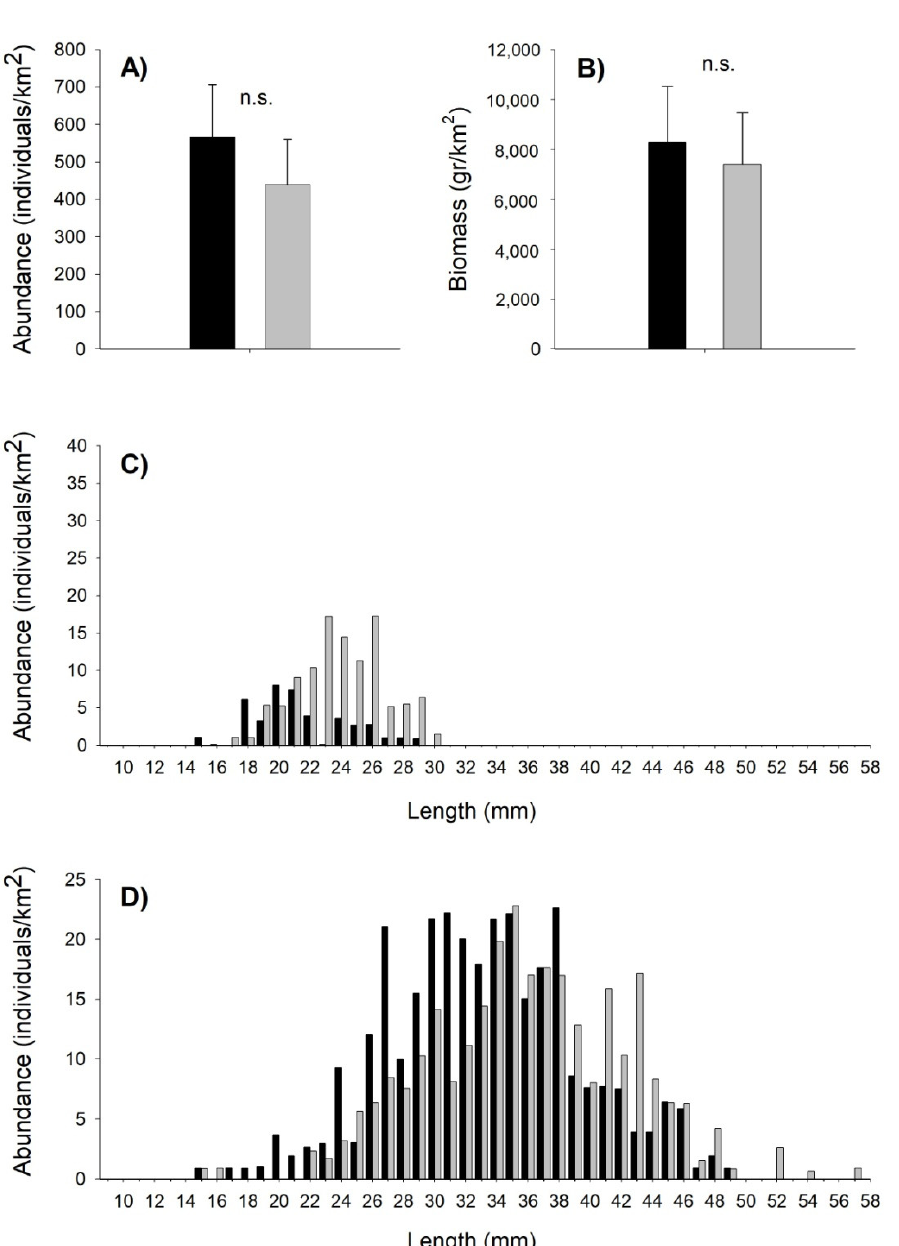
Figure 7. Mean standardized abundance ( A ) and biomass ( B ) and length frequency distribution by males ( C ) and females ( D ) of red shrimp ( Aristeus antennatus ) at fishing grounds adjacent to the Ausias March (black columns) and Emile Baudot (grey columns) seamounts of the Mallorca Channel (Balearic Islands, western Mediterranean). Standard error and results of the Student’s t -test are also shown: n.s. (not significant).